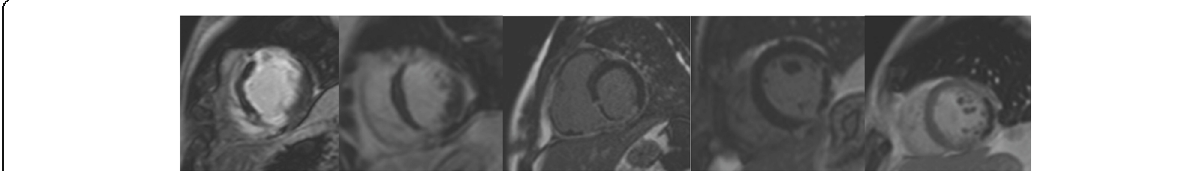
Fig. 1 Late gadolinium enhancement short axis views in different patients showing transmural infarction along the territorial supply of the culprit artery. Areas of microvascular obstruction are represented as dark core signals within the contrast-enhanced infarcted segments